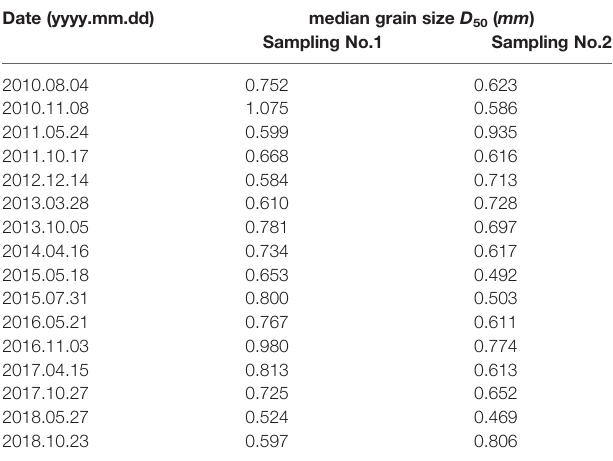
TABLE 5 | Observation of median grain size at Maengbang Beach (The province of Gangwon,